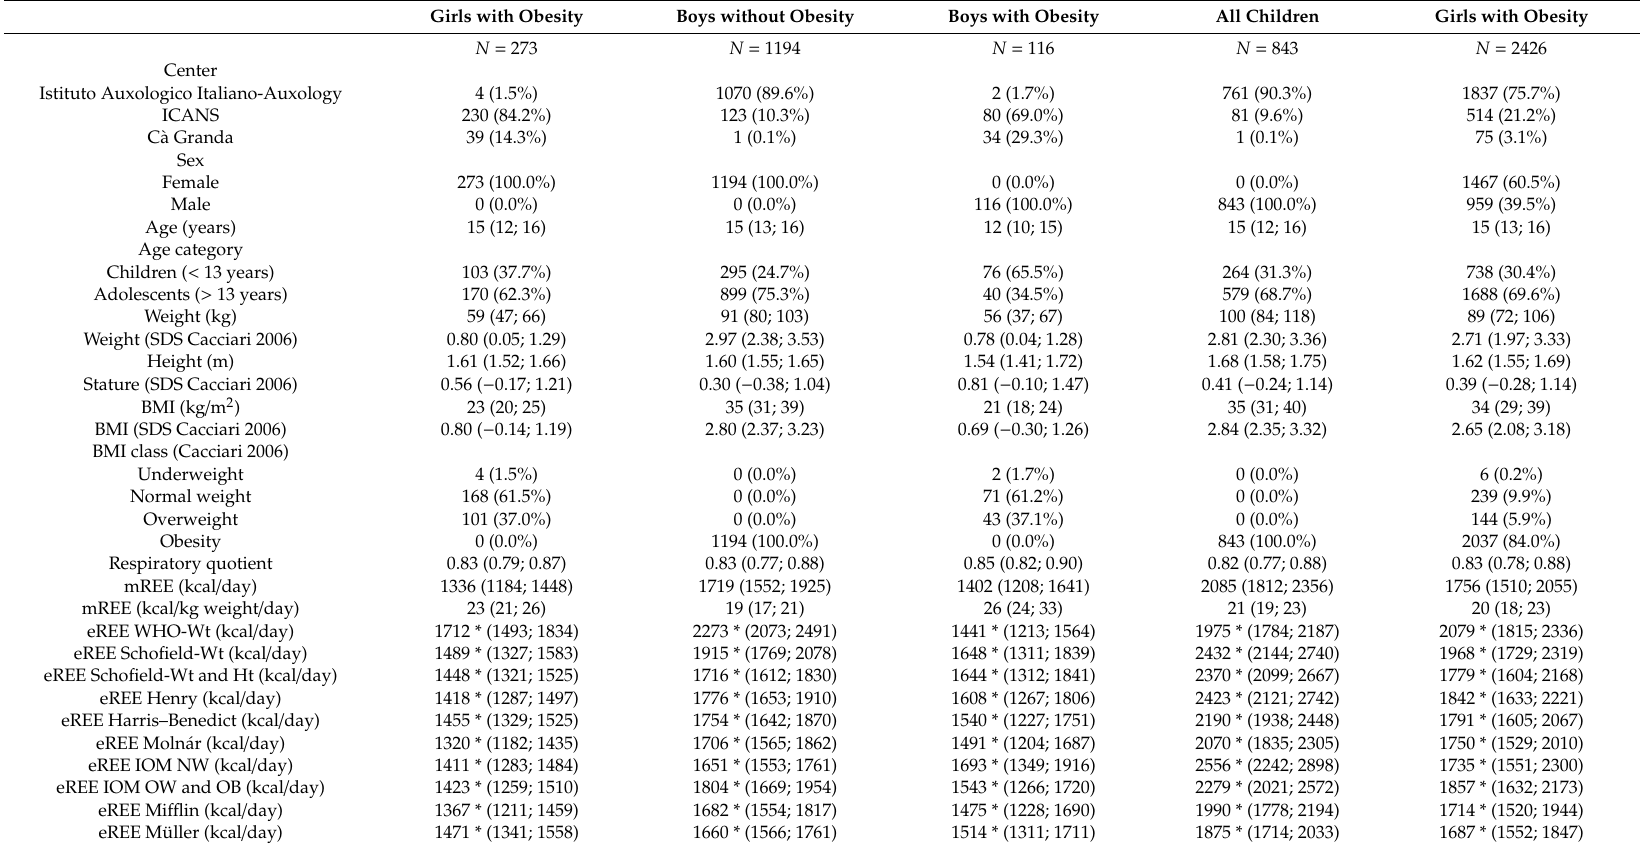
Table 1. Sex, age, anthropometry, and resting energy expenditure of the study